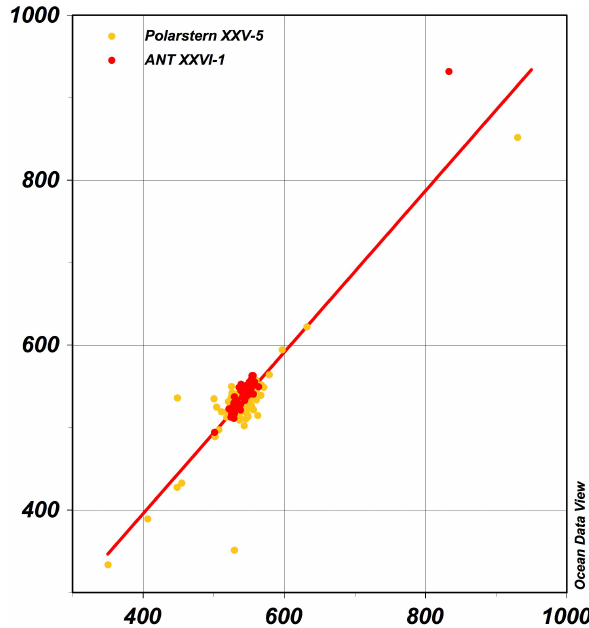
Figure 3. Comparing the H 2 mole fractions (ppb) measured with the isotopic experimental setup ( x axis) and the Peak Performer 1RGA ( y axis) during ANT-XXVI/1 (red labeled) and ANT-XXV/5 (yellow labeled), y = 0.979 x + 3.96, R 2 = 0.81, n =